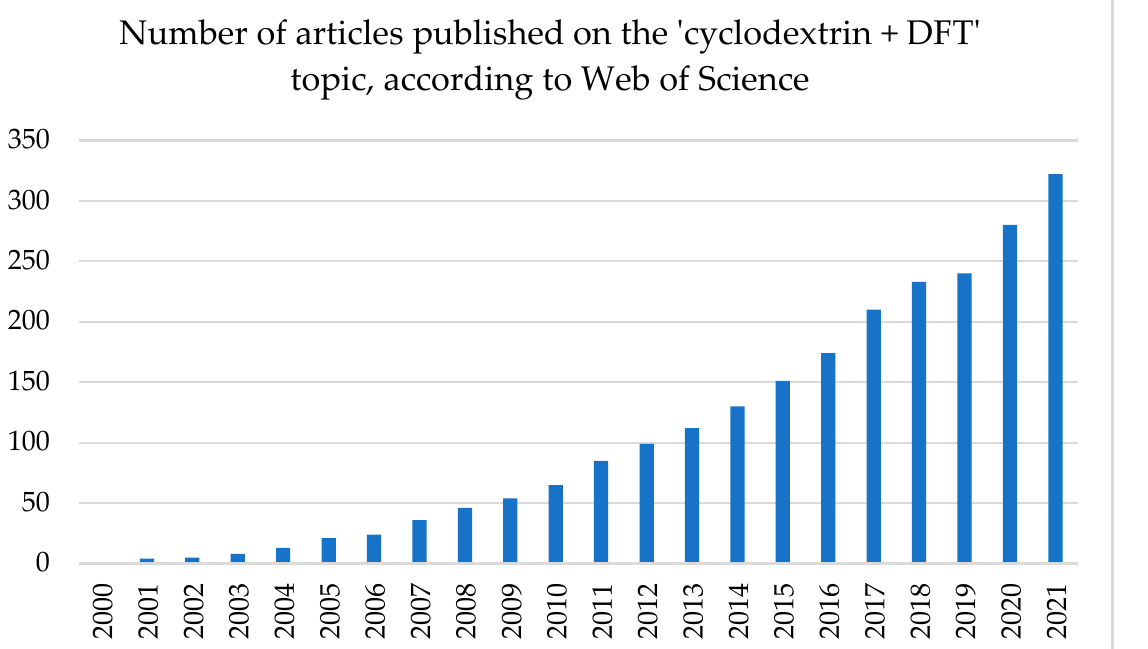
Figure 1. Number of the search results for the ‘cyclodextrin AND DFT’ phrase in the Web of Science. Each column shows the number of articles in the given year and all years before. For example, the column entitled ‘2010’ depicts the number of articles published in the period 2000–2010, including 2010.